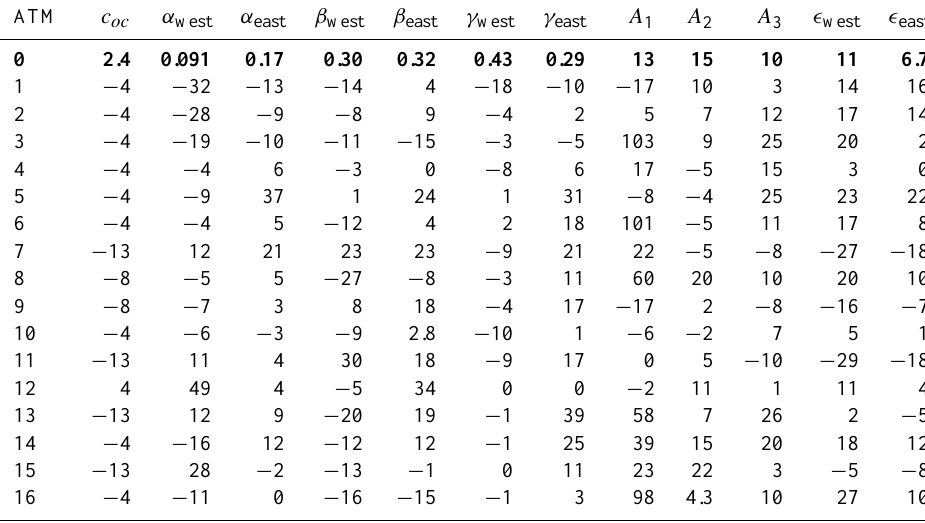
Table 2. Feedback parameters in % of change in the ATM-ensemble relative to the STAM member. The reference mean values of the parameters of the STAM member are also listed, with the values for the Kelvin wave speed c oc in [m/s], α in [0.1Km − 1 month − 1 ], β in [100KPa − 1 month − 1 ], γ in [month − 1 ], the statistical atmosphere in [10 − 3 Nm − 2 K − 1 ] and the atmospheric noise in [10 − 3 Nm − 2 ]. Terms are defined in Eqs. (1) and